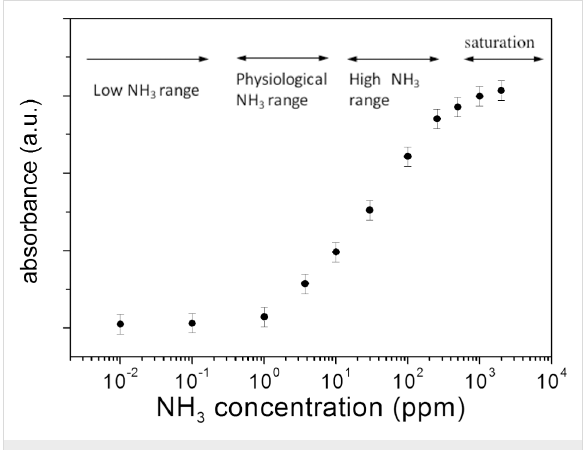
Figure 2: Maximum value of absorbance as a function of the NH 3 con-